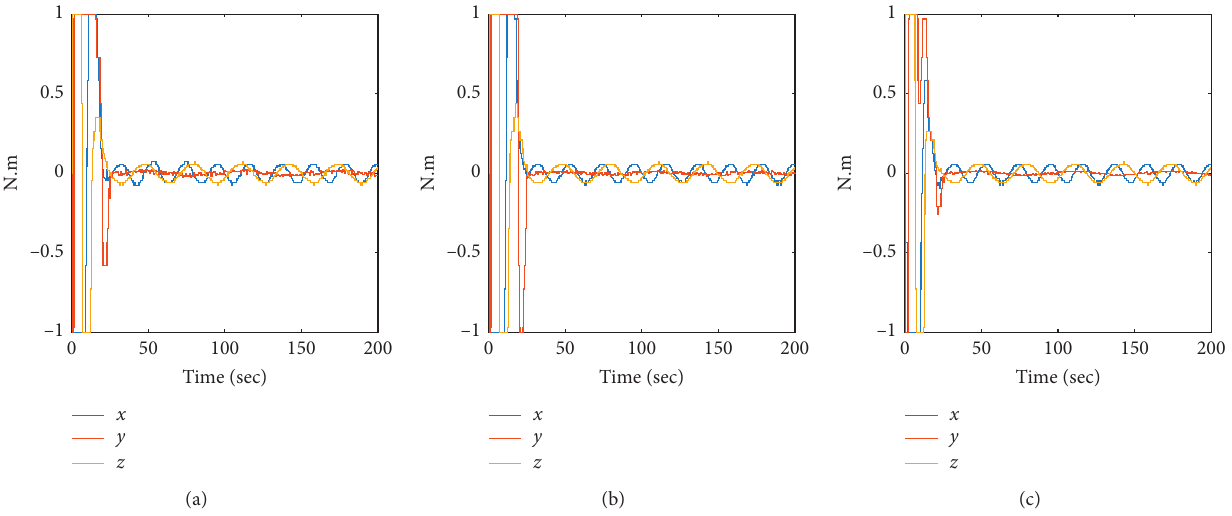
Figure 8: The curves of the quantized control torque. (a) Sat1. (b) Sat2. (c) Sat3.